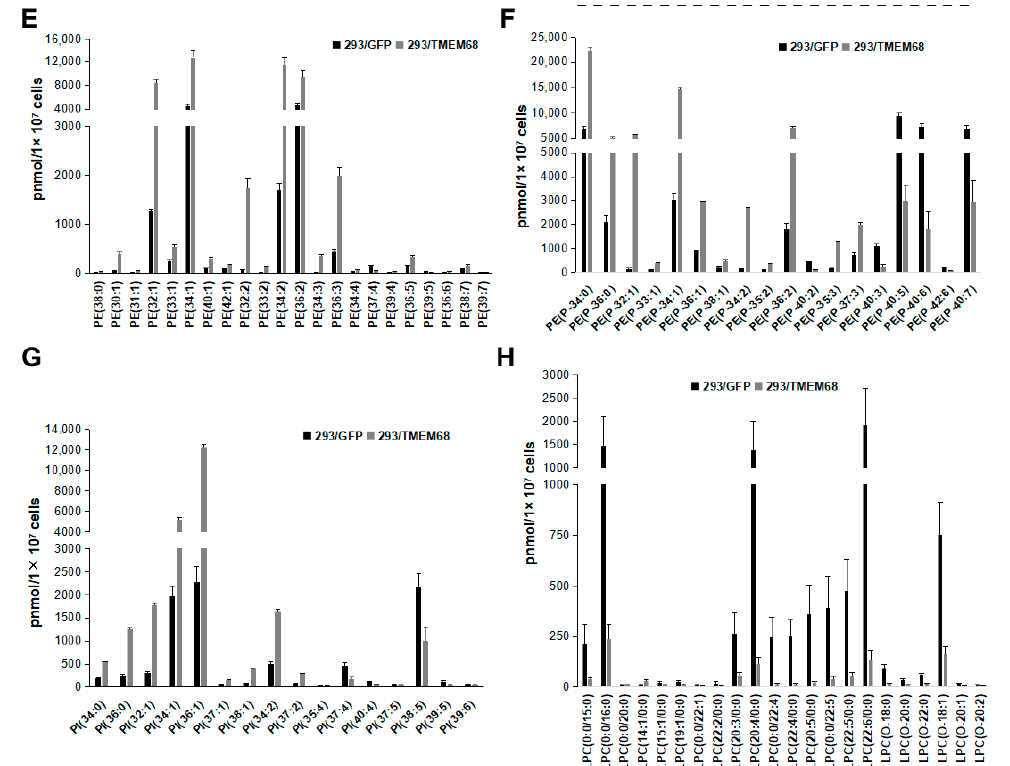
Figure 8. Glycerophospholipids levels were altered by TMEM68 overexpression. A and B, Comparison of total various glycerophospholipids ( A ) and lysophospholipids ( B ) levels between 293/TMEM68 and 293/GFP cells. Data were presented as means ± SD. Asterisk indicated p values: * p < 0.05, ** p < 0.01, n = 6. C-H, Comparing the levels of differentiated PC ( C ), PC-O ( D ), PE ( E ), PE- P ( F ), PI ( G ), LPC and LPC-O species ( H ) between 293/GFP and 293/TMEM68 cells. Differentiated lipids screened by VIP ≥ 1, FC ≥ 2.0 or FC ≤ 0.50 were shown. Data were presented as means ± SD. All p < 0.01, n = 6.